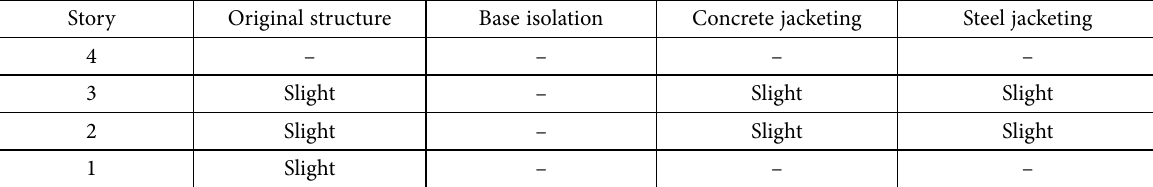
Table 4. Non-structural damage levels for drift-sensitive components